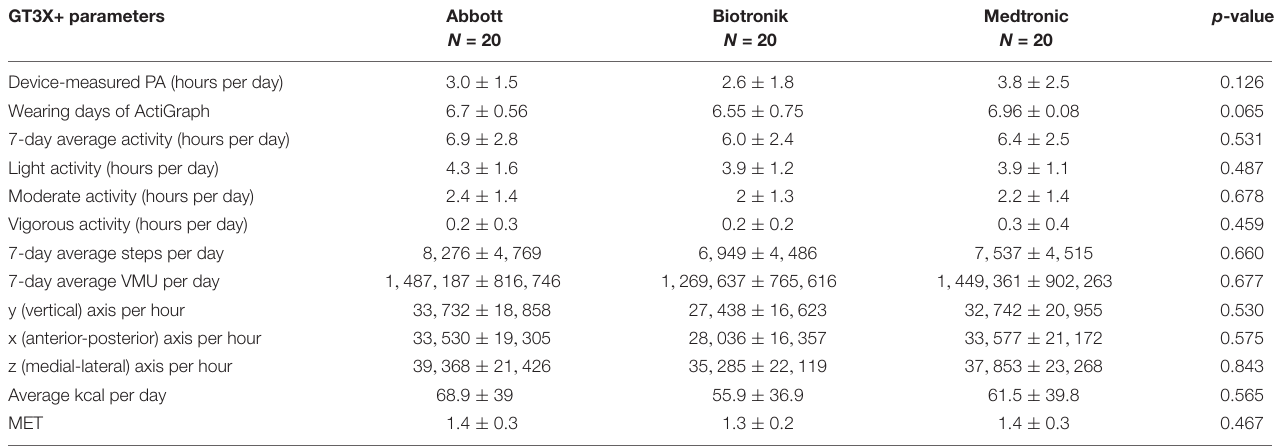
TABLE 2 | ActiGraph GT3X+ and cardiovascular implantable electronic device-measured physical activity of study participants. GT3X+ parameters Abbott